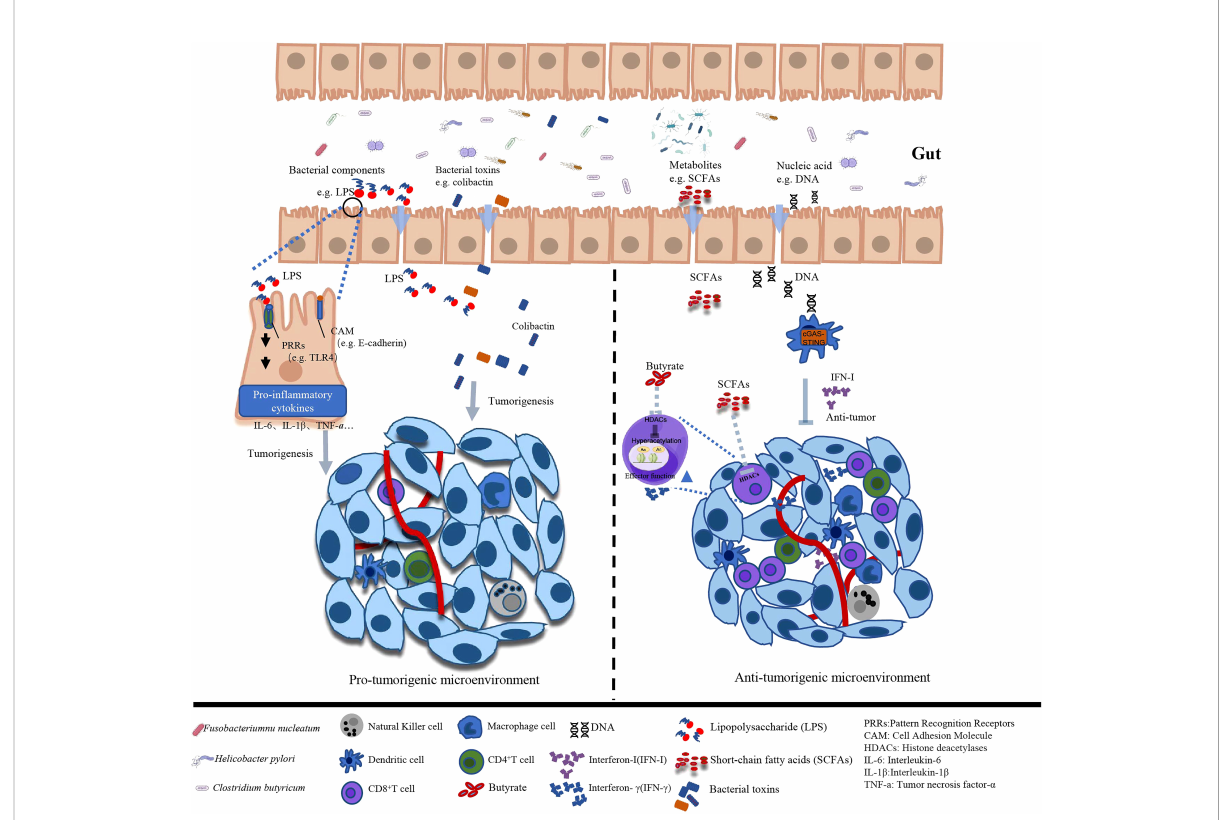
FIGURE 1 Different effects of gut microbiota and associated metabolites on tumor